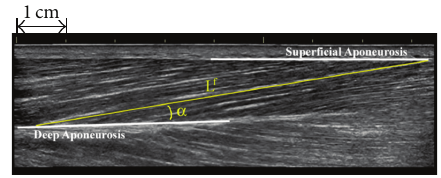
Figure 2: Paretic tibialis anterior fascicle ( 𝐿 f ) and pennation angle ( 𝛼 ) for one subject using extended field-of-view.